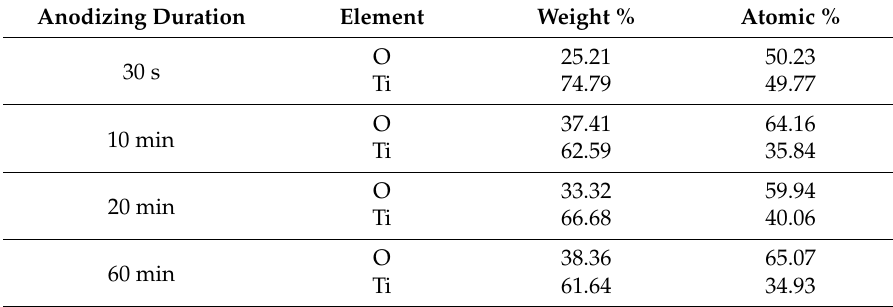
Table 2. Energy-dispersive X-ray spectroscopy (EDX) spectra of annealed TiO 2 at 450 °C for 2 h.